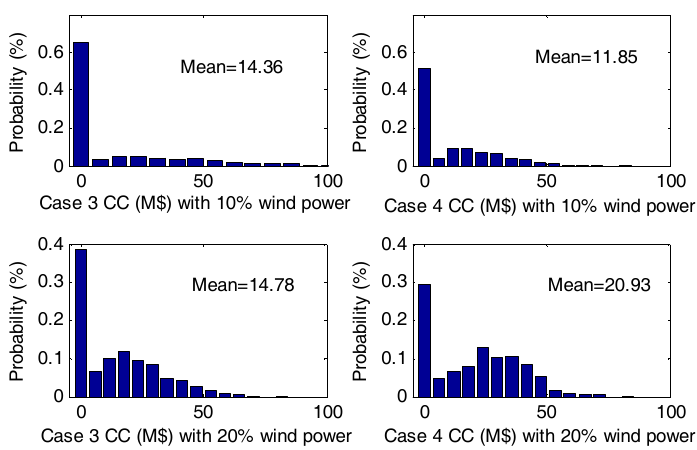
Figure 7. Operation cost (OC) distributions for cases 3 and 4 with increasing wind power.